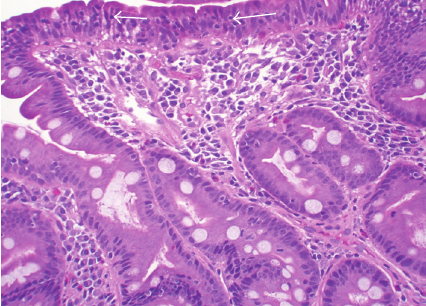
Figure 1: Duodenal biopsy specimen showing villous blunting and intraepithelial lymphocytosis (white arrows). There is also chronic inflammationinthelaminapropriaandcrypthyperplasiaconsistent with gluten sensitive enteropathy (hematoxylin and eosin